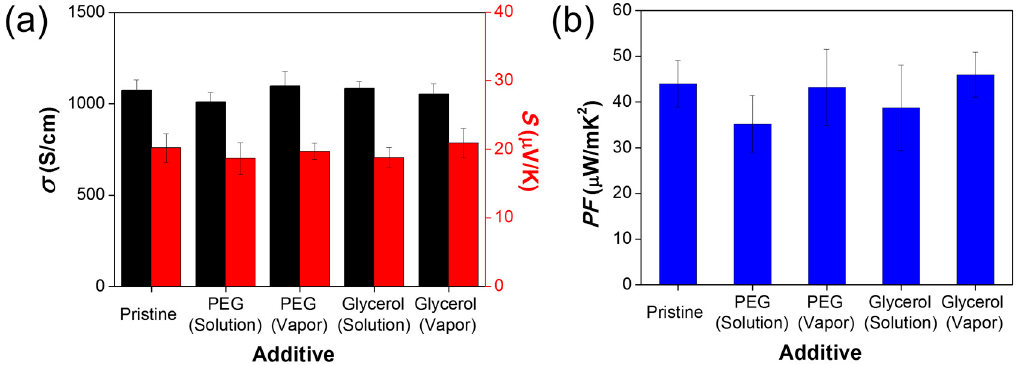
Figure 2. ( a ) σ and S, and ( b ) PF for Pristine, PEG solution-treated, PEG vapor-treated, glycerol solution-treated, and glycerol vapor-treated films.